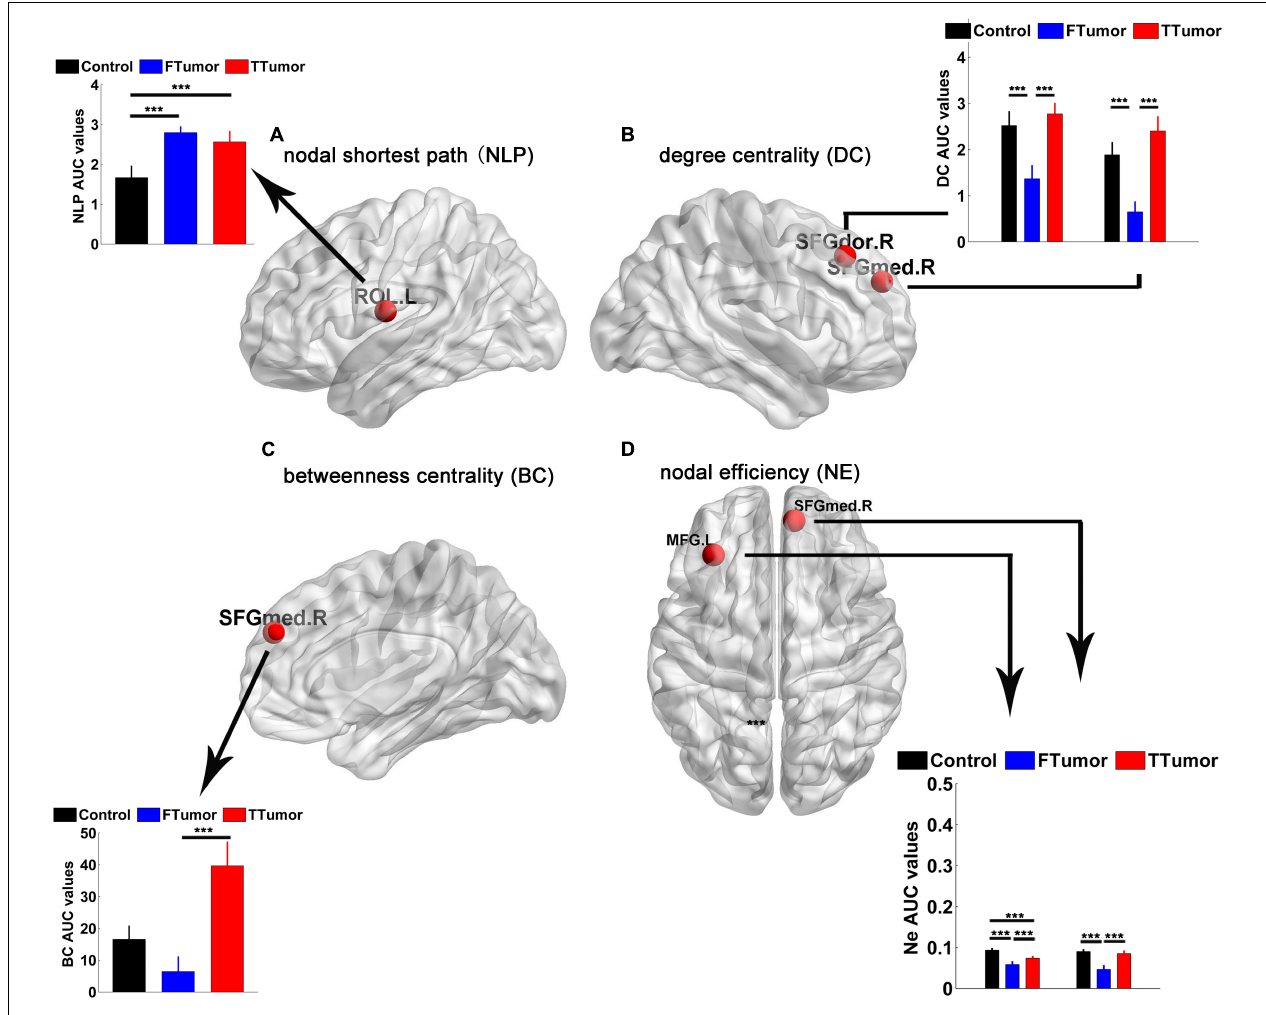
FIGURE 5 | Brain regions showing abnormal regional nodal characteristics of white matter structural networks. (A) Differences on the nodal shortest path of the WM structural network; (B) differences on the degree centrality of WM structural network; (C) differences on the betweenness centrality of WM structural network; (D) differences on the nodal efficiency of WM structural network among CN, FTumor, and TTumor patients. FTumors, frontal tumors; TTumors, temporal tumors; WM, white matter; N Lp , nodal shortest path; DC, degree centrality; BC, betweenness centrality; NE, nodal efficiency; ROL.L, left rolandic operculum; SFGdor.R, right superior frontal gyrus, dorsolateral. SFGmed.R, right superior frontal gyrus, medial; MFG.L, left middle frontal gyrus; AUC, area under the curve. *** p <